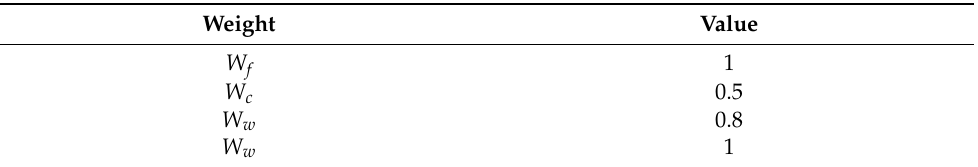
Table 6. Vegetation-specific weights used to calculate the WMCGI (forest = 1, cropland = 0.5, grassland = 0.8, wetland = 1). Weight Value W f 1 W c 0.5 W w 0.8 W w 1